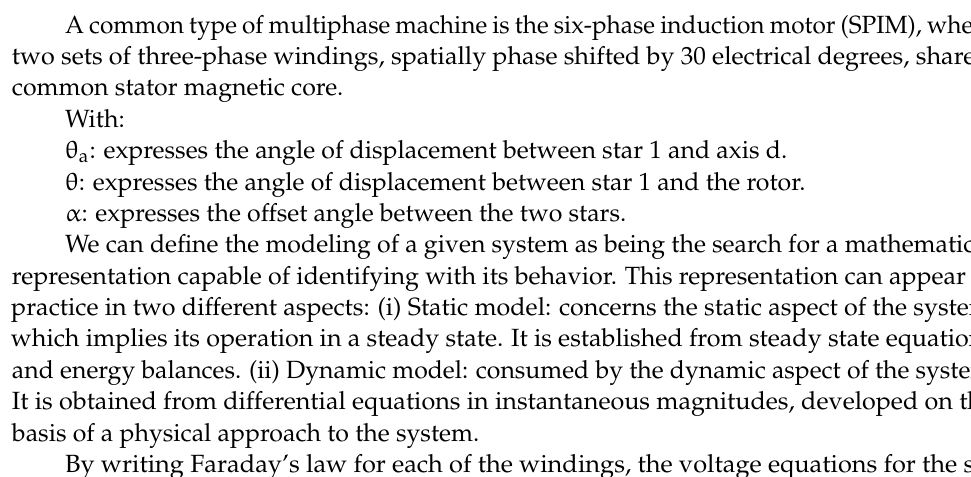
common stator magnetic